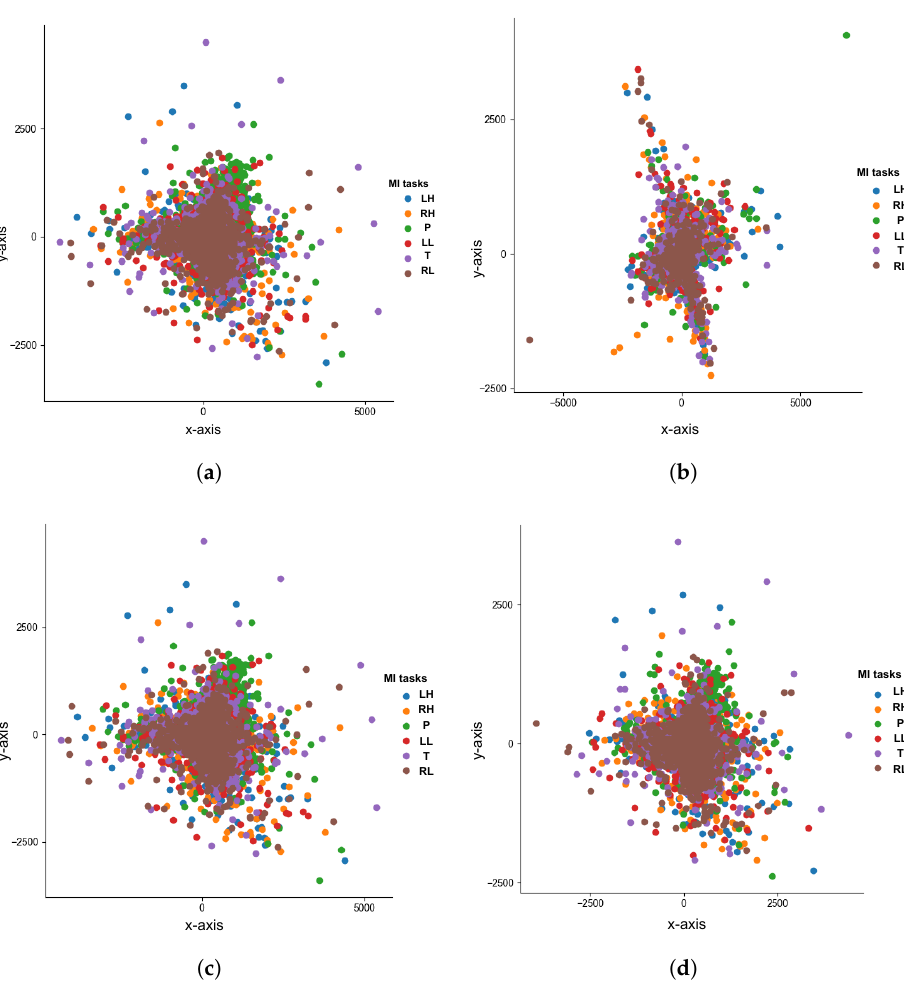
Figure 5. t-SNE distribution illustrations of selected channels’ signals for all subjects using the ARbC method and CMIbA before the main processing step. All figures were plotted in 2-D embedded space using the Euclidean metric, setting the nearest neighbors’ number at 10, the number of iterations for the optimization at 1000, and the gradient norm at 0.0001. ( a ) ARbC: six-channel combination: distribution of {Fp1,F8,Fp2,F7,P3,Cz} channel signals, ( b ) CMIbA: six-channel combination: distribution of {P4,T6,T3,P3,F4,O2} channel signals, ( c ) ARbC: eight-channel combination: distribution of {Fp1,F8,Fp2,F7,P3,Cz,O1,P4} channel signals, ( d ) CMIbA: eight-channel combination: distribution of {P4,T6,T3,P3,F4,O2,Fp2,Fz} channel